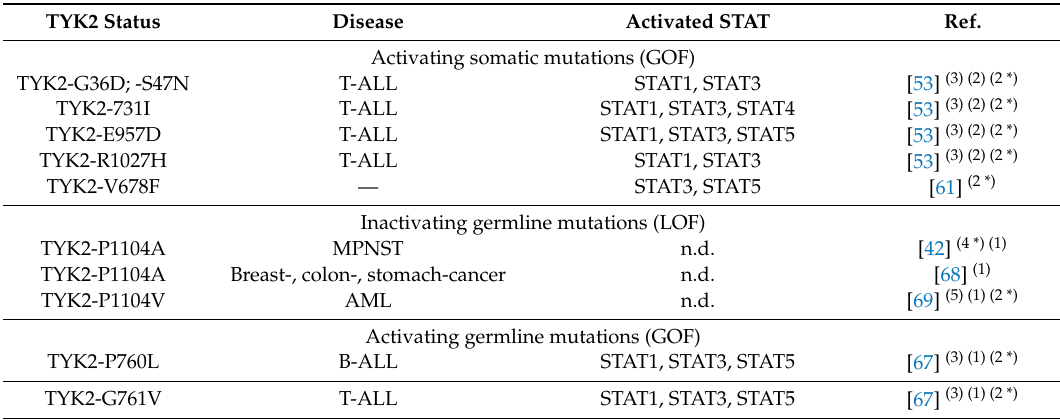
Table 1. (Hyper-)active TYK2, GOF-, or LOF-mutated TYK2 and STAT activation in various cancers and cancer cell